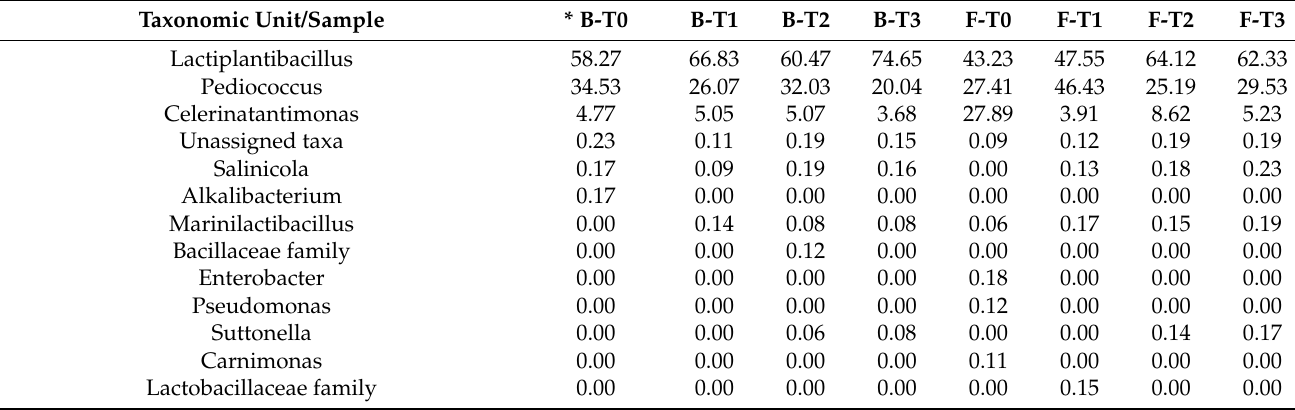
Table 2. Relative abundance of sequences (%) to different taxa levels, obtained by metataxonomic analysis of 16S data samples belonging to traditional packed Aloreña de M á laga . Mean values were obtained from independent duplicates. Only those taxa with abundance >0.1% in at least one sample are shown.